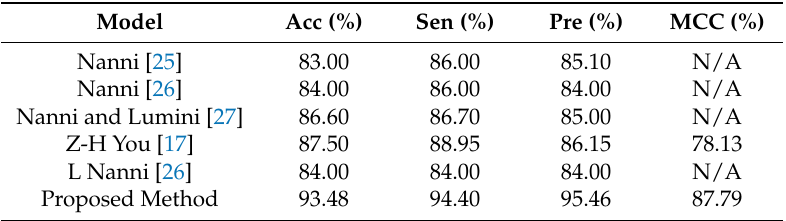
Table 7. Practical predicting results of different methods on the H. pylori dataset. N/A: Not